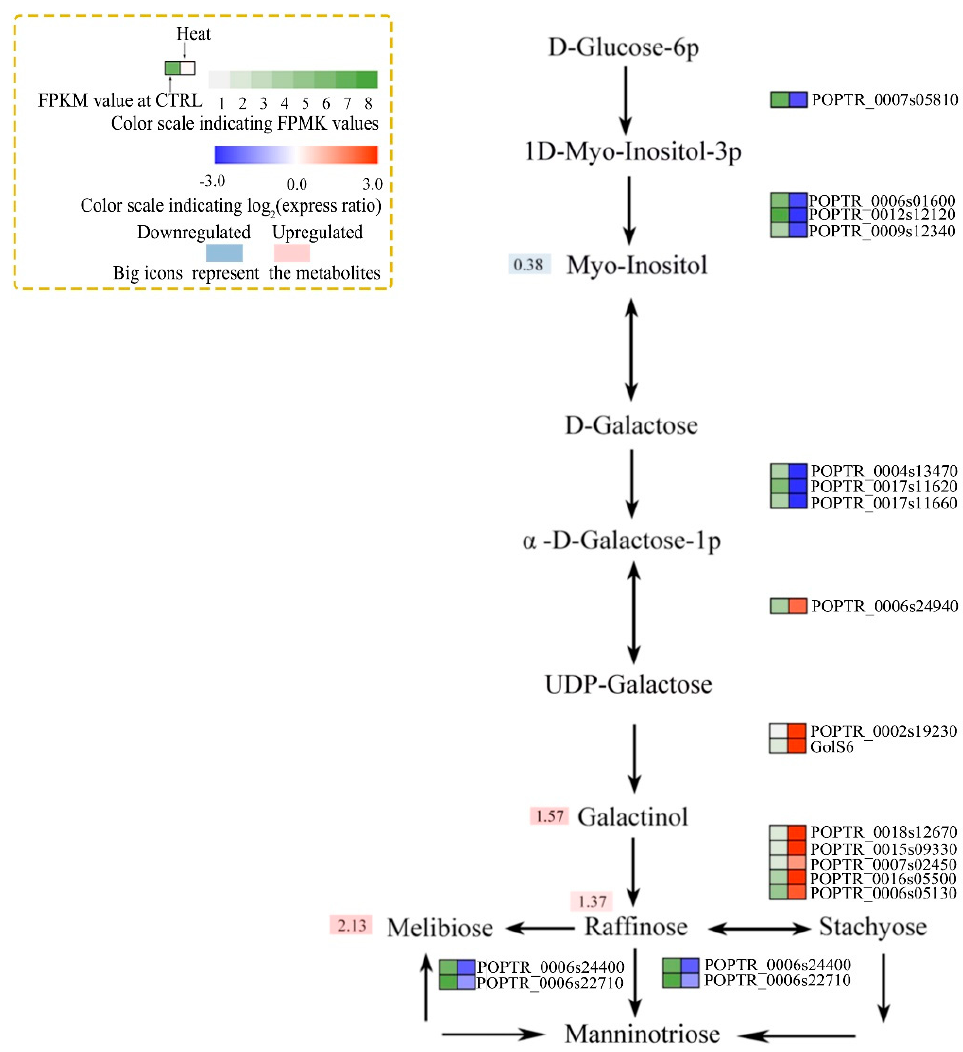
Figure 6. Associated pathway analysis of metabolite levels and enzyme activities. Inositol phosphate metabolism and galactose metabolism pathways. Metabolites whose levels did not differ were omitted. Colors at right indicate the log 2 expression ratio [log 2 (heat/control_ mean)], and at left, the FPKM value of the control. (Levels 1–8, FPKM values of 0–10, 10–20, 20–40, 40–80, 80–160, 160–320, 320–640, and 640+, respectively). Large icons, metabolites; red, upregulation; blue, downregulation.